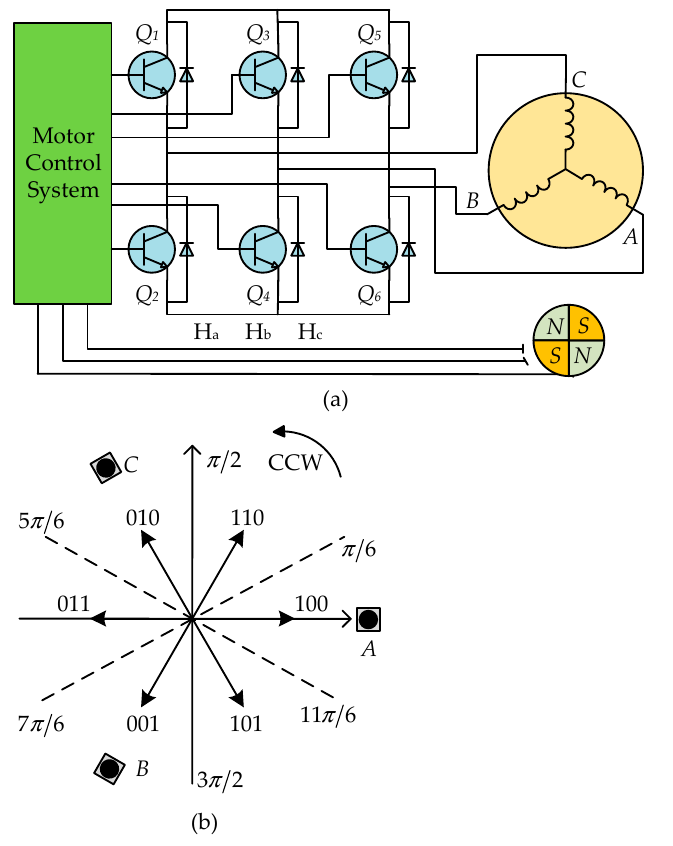
Figure 1. The Permanent magnet brushless direct current (PMBLDC) motor drive and Hall sensors: ( a ) the structure of PMBLDC motor drives; ( b ) the simplified view of the Hall sensors in the PMBLDC drives.